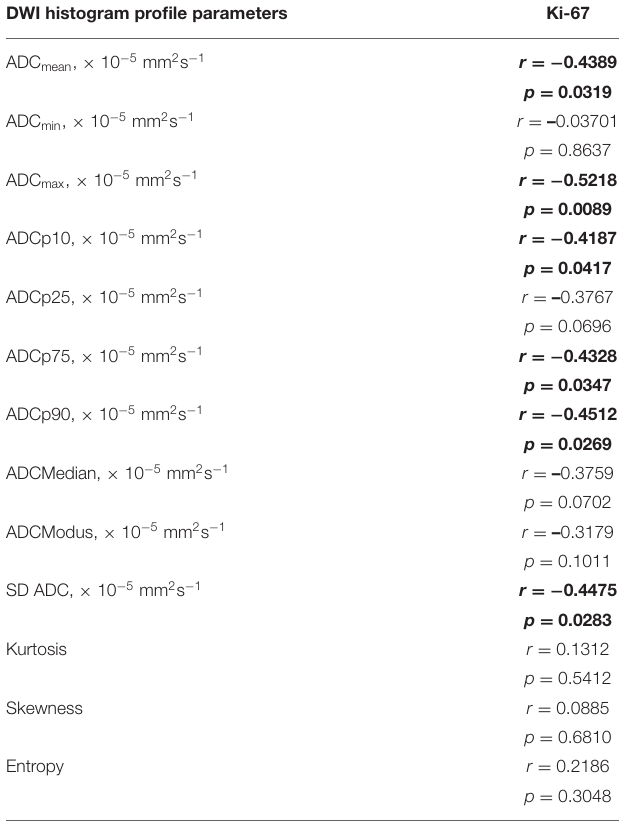
TABLE 5 | Correlations between DWI histogram profile parameters and Ki-67 in all investigated gliomas. DWI histogram profile parameters